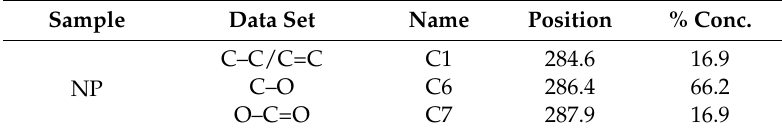
Figure 6. F 1s peak of the new pressboard, pressboard surface coated PTFE film for 10 min and 20 min. Table 3. C 1s peak fitting result for NP, NP-PTFE10, and